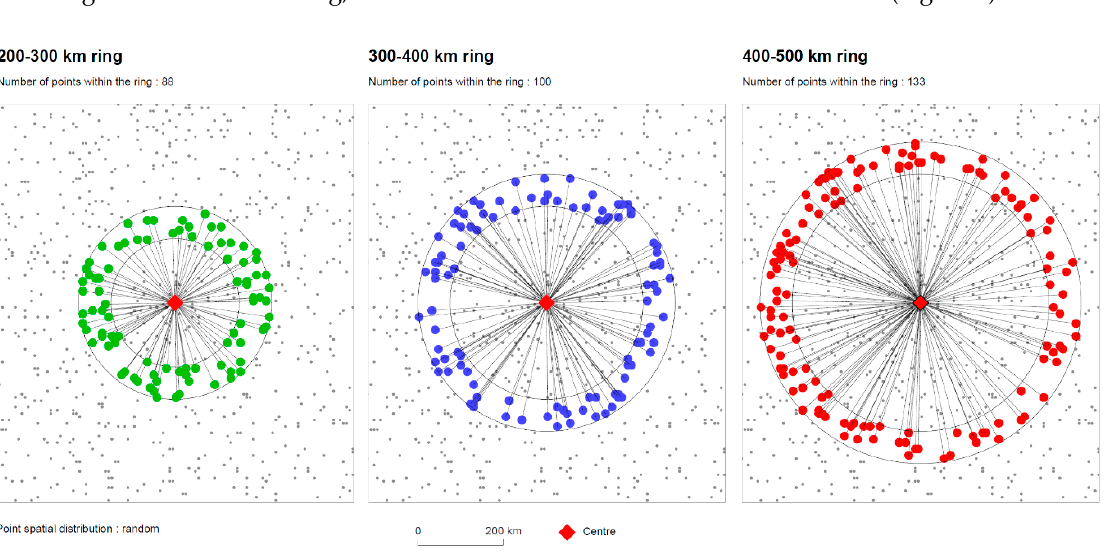
Figure 1. Number of points in rings of increasing radius and same width, for points independently and uniformly distributed in a 2D space.